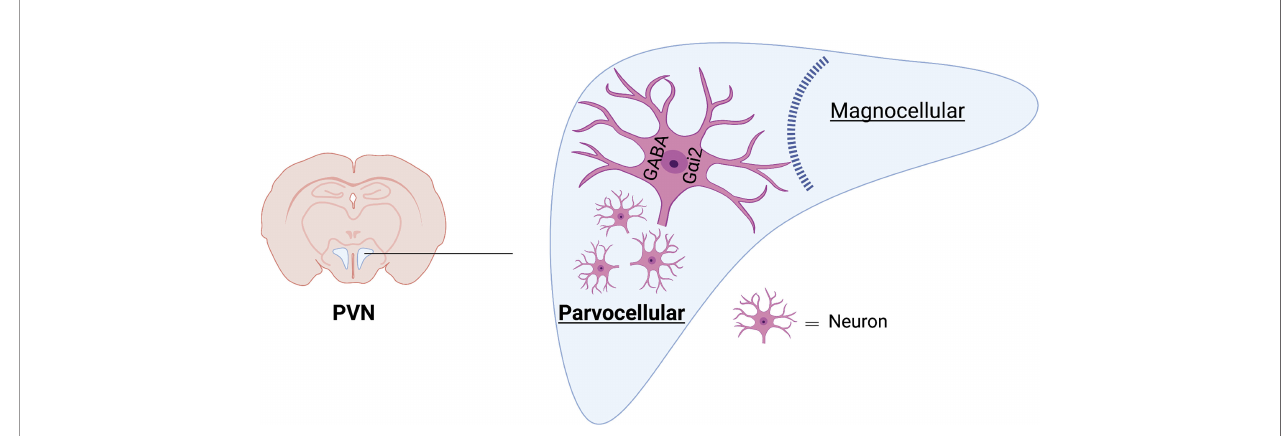
FIGURE 5 | Schematic representation of neuroanatomical localization of G a i2 mRNA-expressing neurons in PVN. G a i2 mRNA expressing neurons are highly localized within the parvocellular region of the PVN and strongly colocalize with GABAergic neurons. Image was generated using